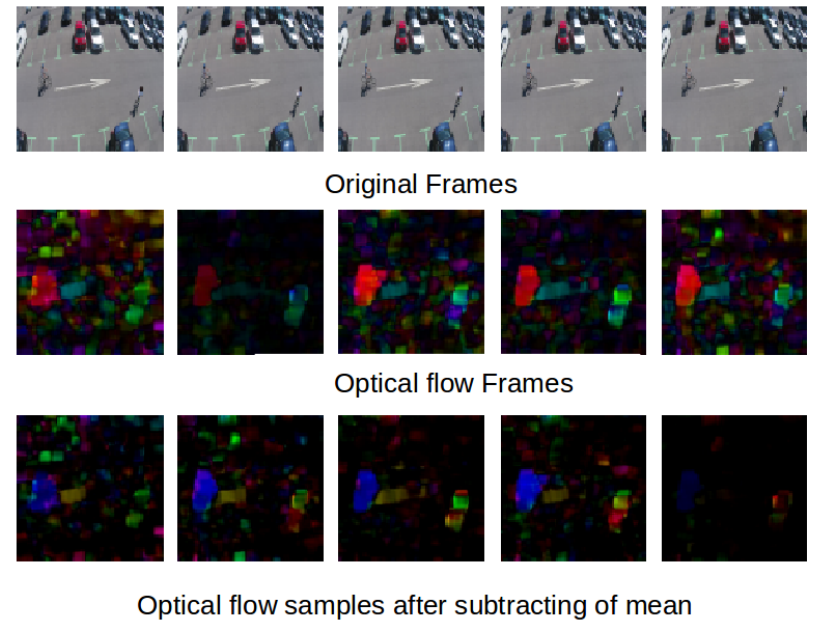
Figure 5. Subtraction of mean optical flow in the MDVD